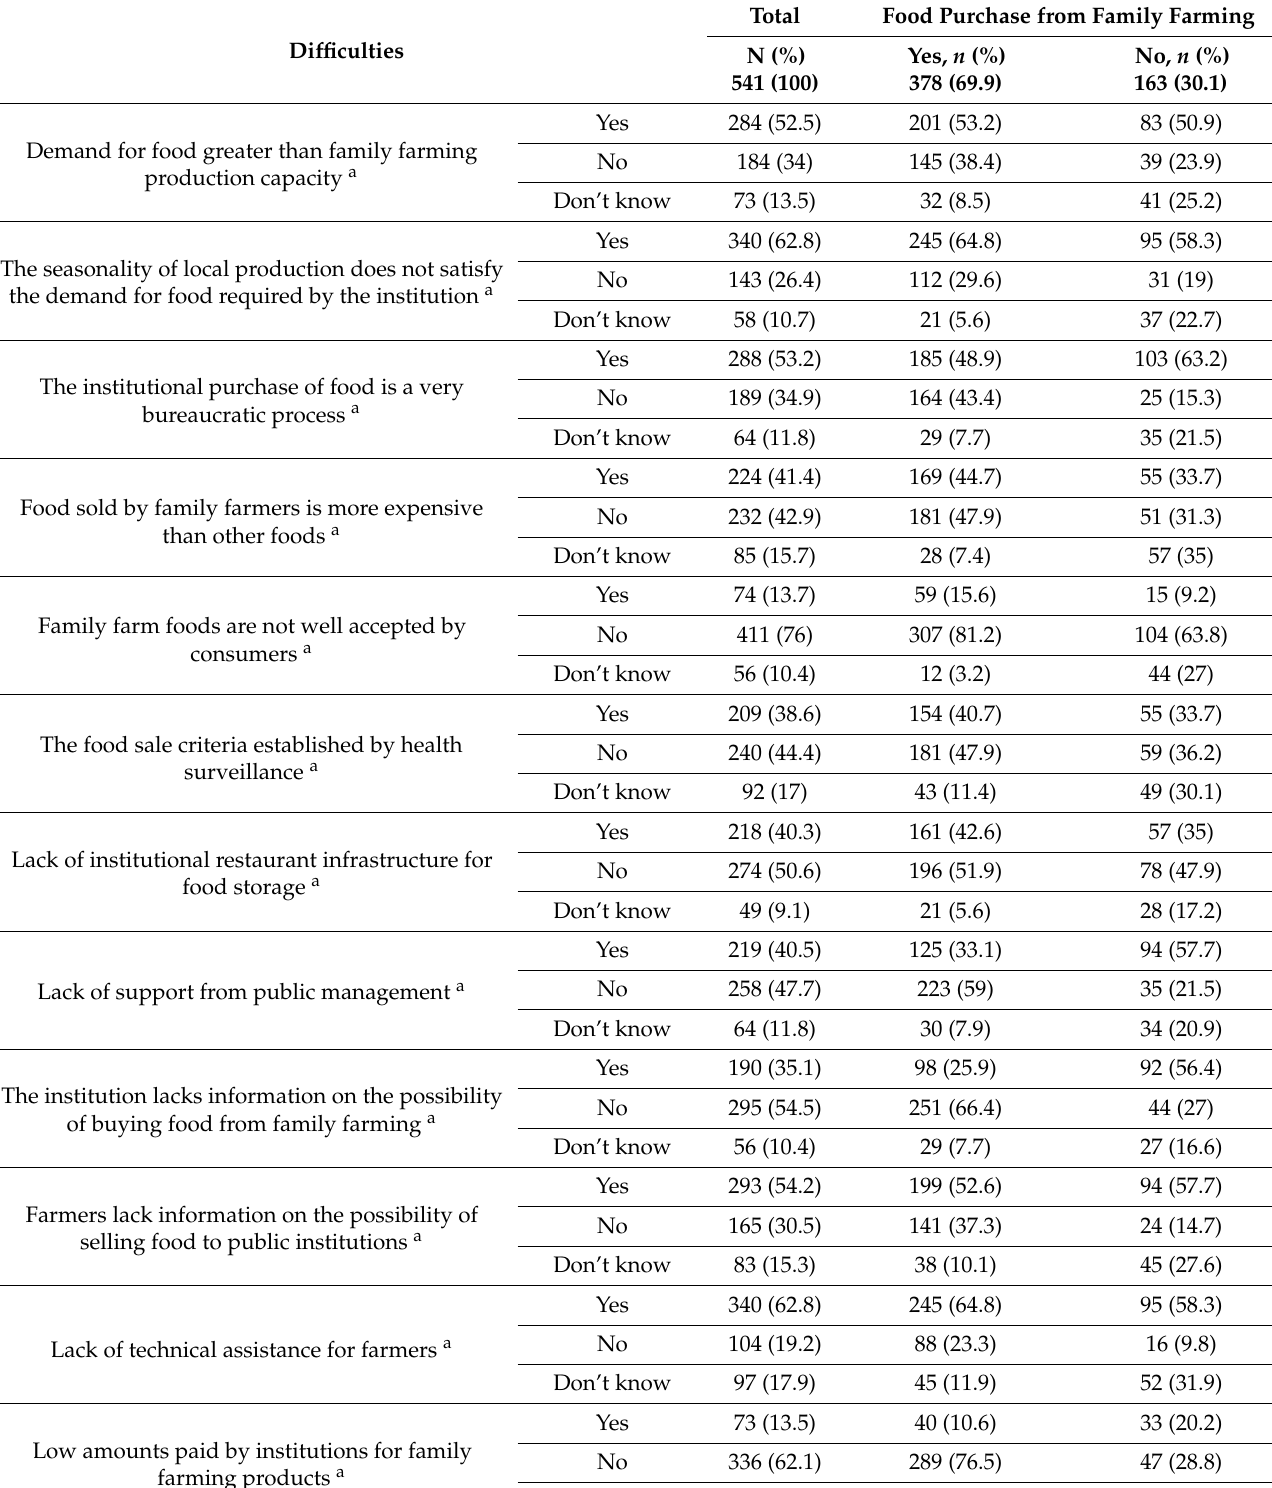
Table 3. Opinion of the study participants concerning the difficulties of buying food from family farming in public institutional food service, stratified according to the family farmers’ food